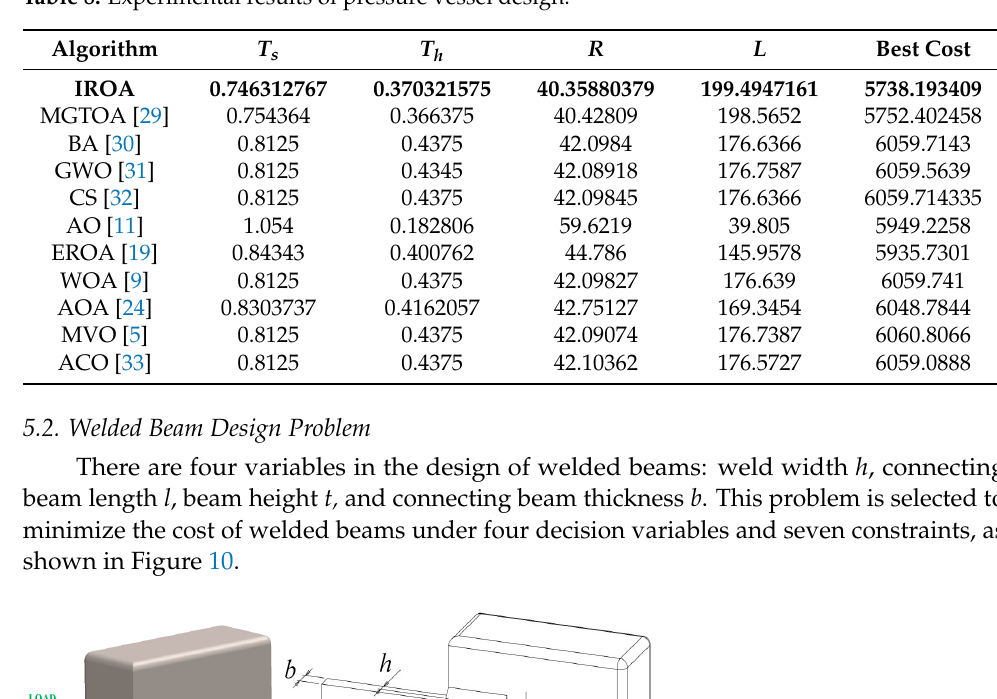
Table 8. Experimental results of pressure vessel design.